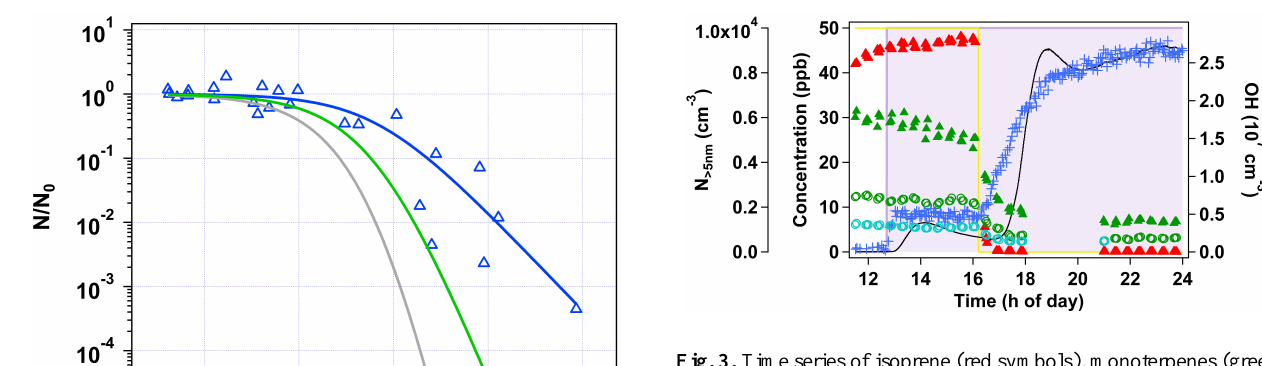
Fig. 3. Time series of isoprene (red symbols), monoterpenes (green triangles, for clearer visualization MTx20 is displayed), sesquiter- penes (green circles) and MeSA (light blue circles) as measured with the PTR-MS. Switching off the photosynthetic active radiation in the plant chamber (yellow line) causes an instantaneous drop of isoprene emissions to nearly zero. OH concentrations (blue crosses) increase after isoprene decrease, subsequently followed by an in- crease of particle number density (black dotted line). The purple shaded area indicates the time during which OH was produced by O 3